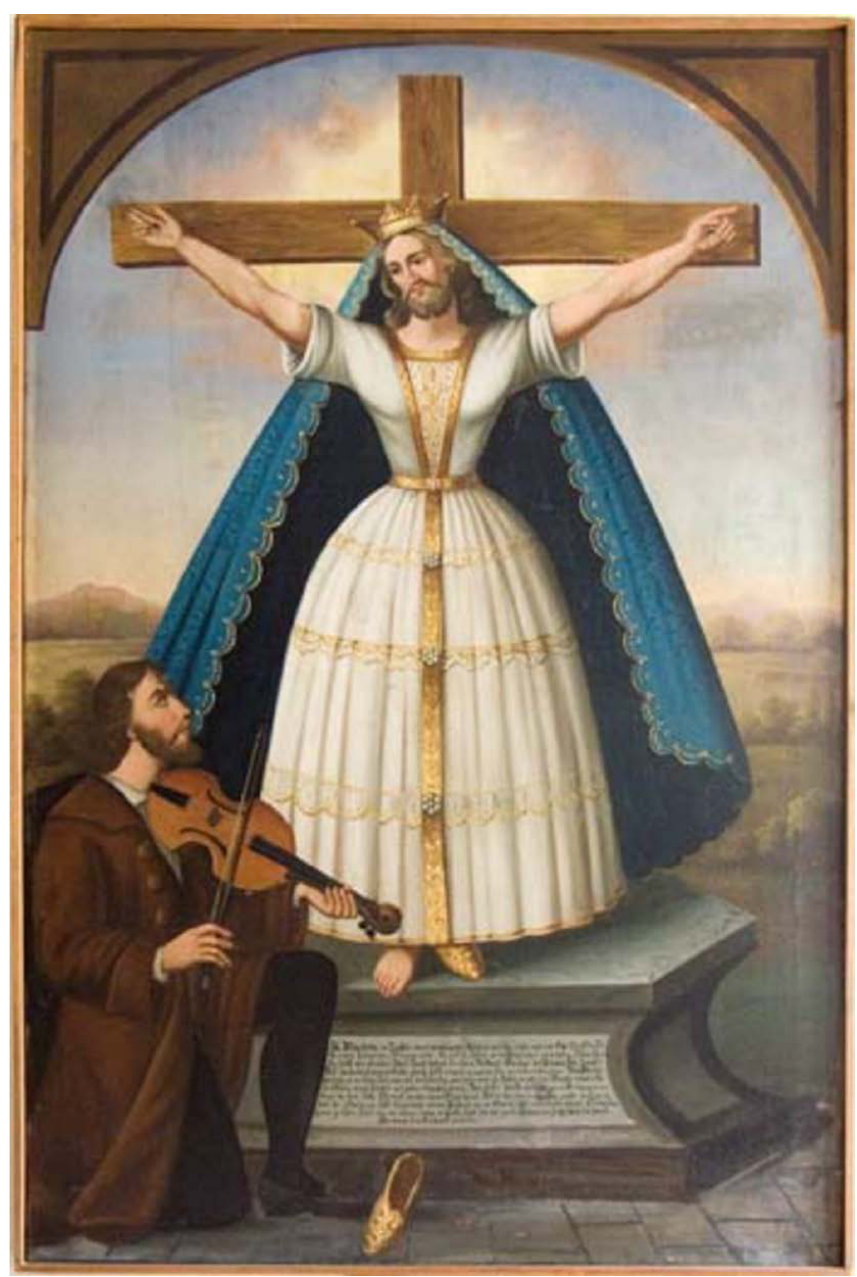
Figure 7. Wallfahrtsbild Kümmernis aus Schwarzau am Steinfeld, Öl, Relig. Brauchtum, Widmung des H. Pfarrers Berger, Schwarzau a. St. Anonymous. Städtisches Museum Neunkirchen. Photo Credit: Public Domain, licensed from alamy.com by the